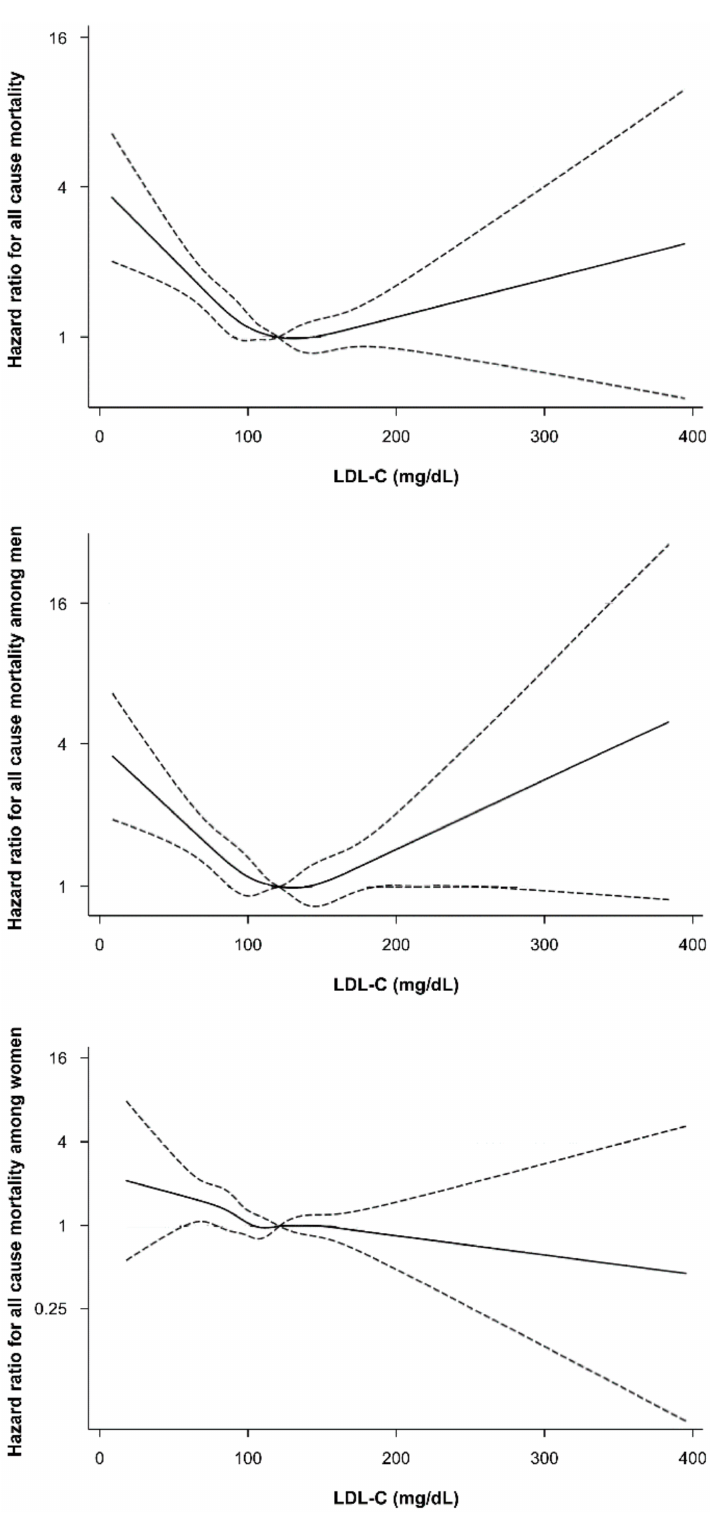
Figure 1. Spline plot of plasma low-density lipoprotein cholesterol and all-cause mortality rate, normalized to the mortality rate at low-density lipoprotein cholesterol of 100–129 mg / dL. The adjusted hazard ratios and 95% confidence intervals were calculated with Cox proportional-hazards models after adjusting for adjusted for age, BMI, smoking status, alcohol intake, regular exercise, education, house income, marital status, diabetes, and hypertension, and high-density lipoprotein